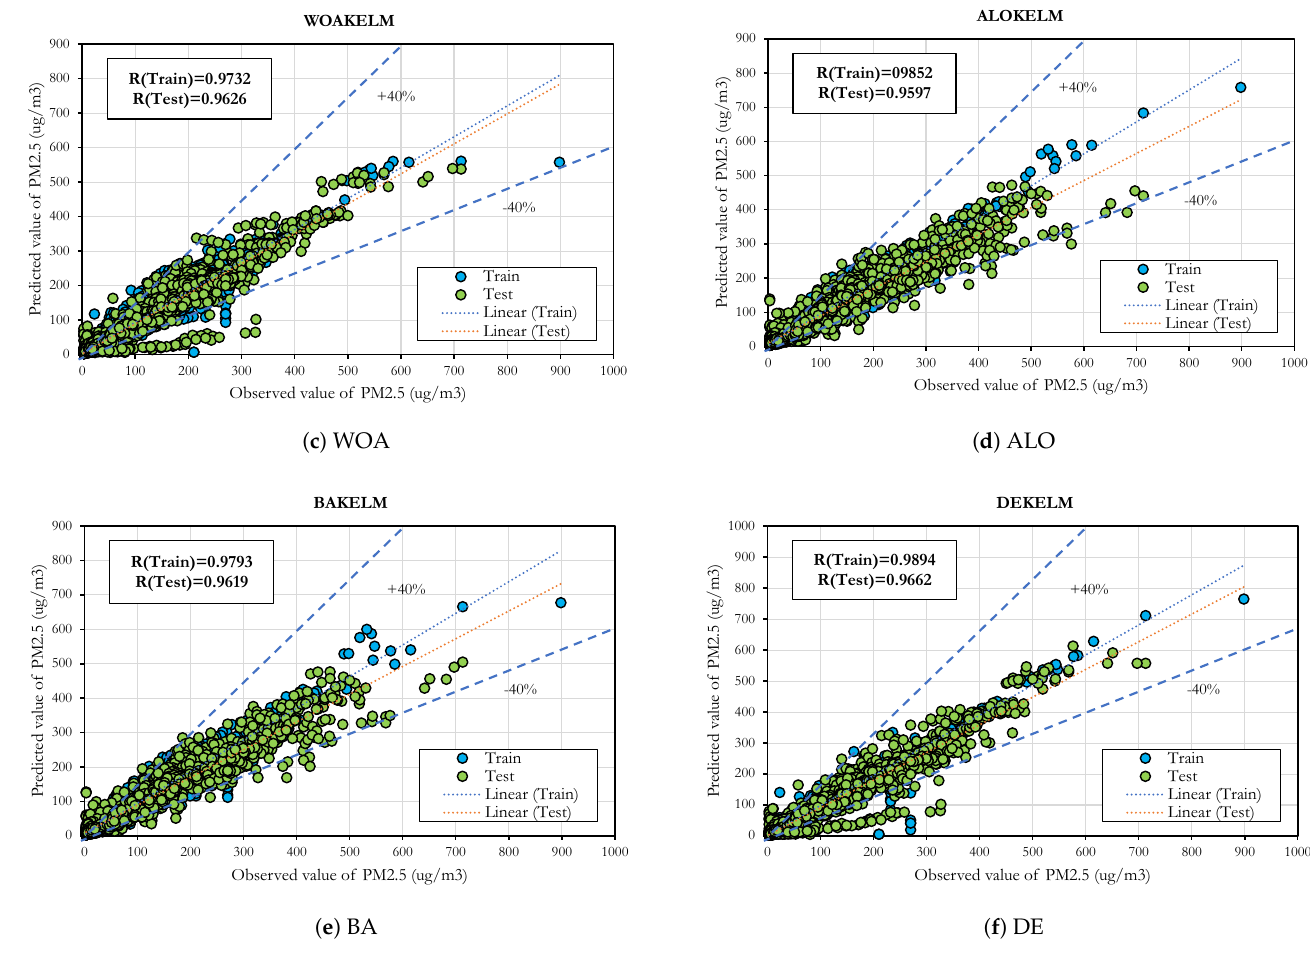
Figure 12. Scatter plots of different optimized KELM